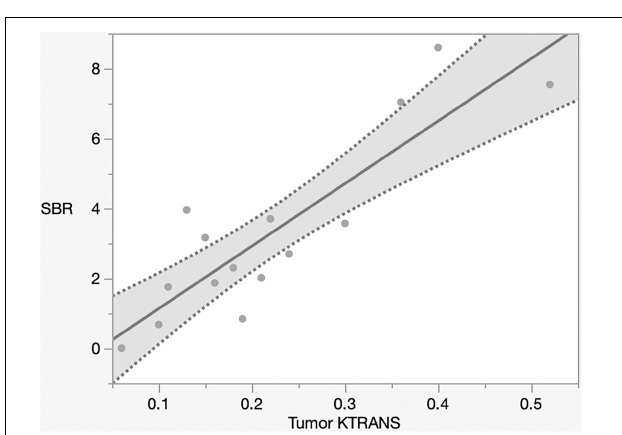
FIGURE 6 | Linear regression plot of NIR; MRI signal intensity ratio of the tumor on T1-contrast scan versus K trans on MRI. T1BR increased with K trans ( p = 0.013, R 2 = 0.56). NIR, near-infrared; MRI, magnetic resonance imaging; SBR, signal–background ratio; K trans , volume transfer constant; T1BR, ratio of gadolinium-enhanced T1 tumor signal to the